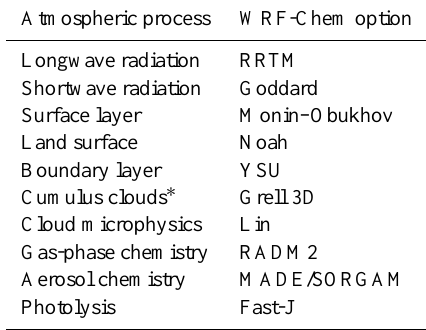
Table 3. Selected WRF-Chem configuration